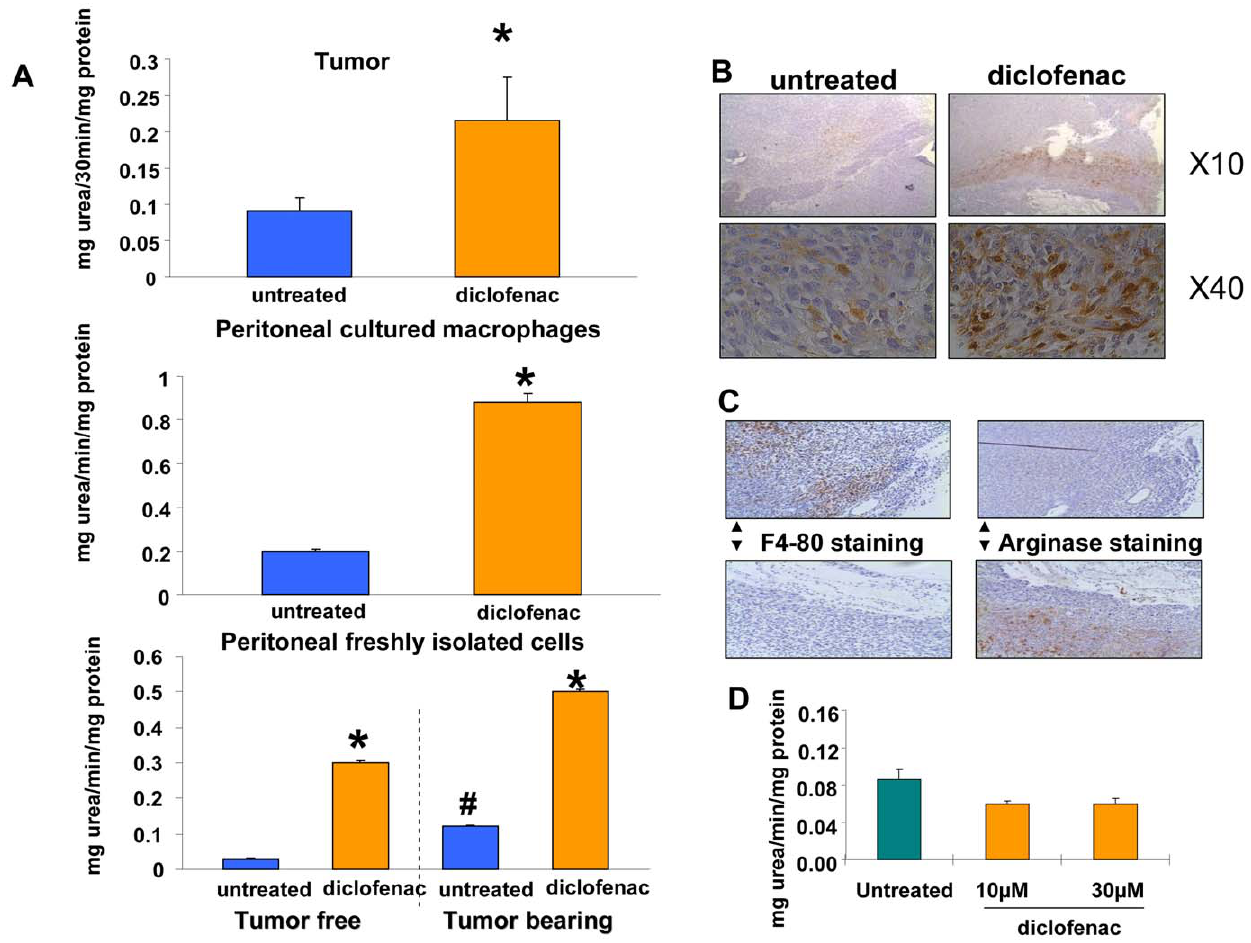
Figure 4. Diclofenac enhances arginase activity in tumors, peritoneal cultured macrophages and in freshly isolated peritoneal cells, but only when introduced invivo and not invitro . A–C, all mice except those indicated were inoculated with tumors on day 1 and killed on day 14. A, arginase activity was measured as described in Materials and Methods in tumor homogenate (top) , in macrophages isolated by peritoneal cavity flush and cultured for 20 hrs ( center) , and in freshly isolated peritoneal cells ( bottom) . Mice were treated with diclofenac 30 mg/kg for 11 days ( top and center ) or for 2 days before the end of the experiment ( bottom ). The results are mean 6 SE of arginase activity in tumor homogenates of 6–7 mice in each group ( top ) or in Triton X-100 dissolved cells obtained from 3–7 mice through peritoneal flush and measured in quadruplicates ( center and bottom ). Each experiment was repeated at least 3 times and the results of the representative experiment are shown. * significantly different from untreated group P # 0.01. # significantly different from untreated group of tumor- free- mice. B, arginase-1 staining of tumors. Fixated tumors were stained for arginase 1 as described in Materials and Methods. Photographs of sections were taken under X 10 (top) or X 40 ( bottom ) magnification. C, The identification of two separate populations of cells in tumor (diclofenac-treated) stroma: F4-80 positive and arginase positive cells. The serial sections were stained for F4/80 (left ) and for arginase 1, (right) . The same areas were identified and compared for the presence of both markers. Photographs of sections were taken under X 20 magnification. One experiment, representative of 2. D, Diclofenac does not induce arginase activity when incubated with macrophages in cell culture. Peritoneal macrophages were isolated from tumor-free mice as described in Materials and Methods and incubated for 48 hours with 10 or 30 m M diclofenac followed by arginase measurement. Mean 6 SE of arginase activity of 3 wells in each group. One experiment, representative of 3.